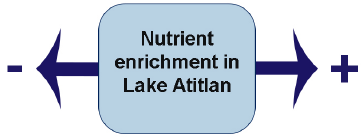
Figure 3. The single-driving-force